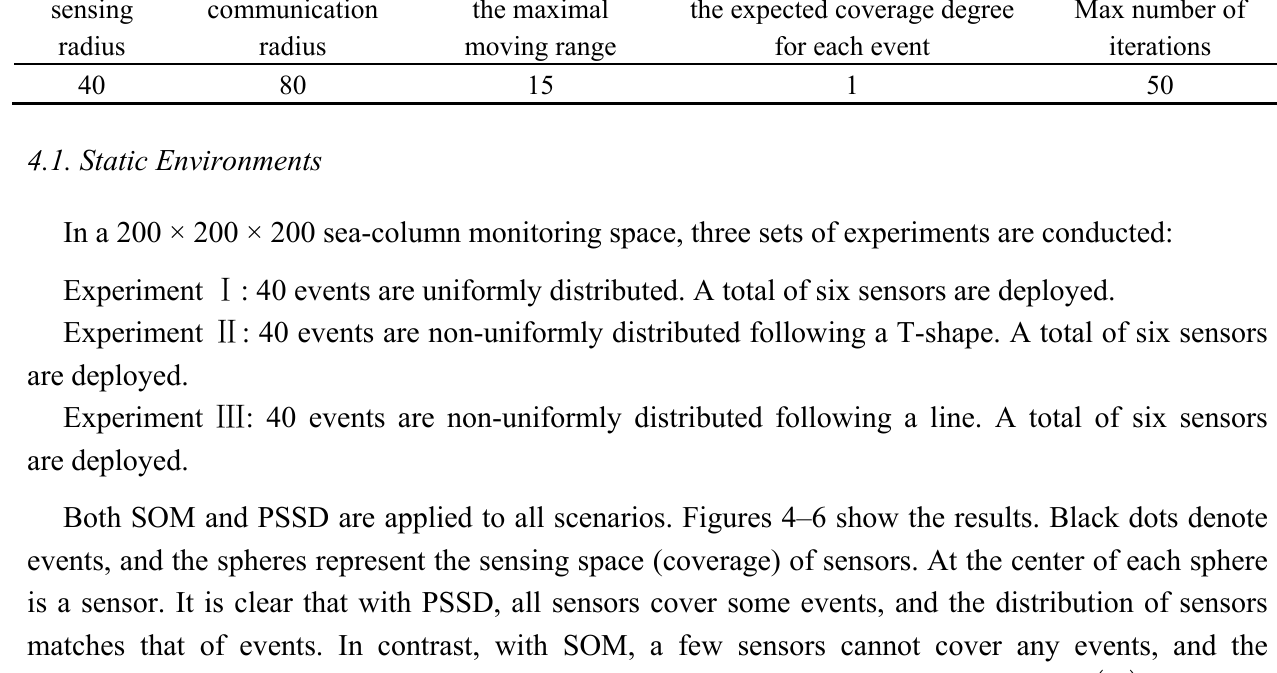
Algorithm parameters